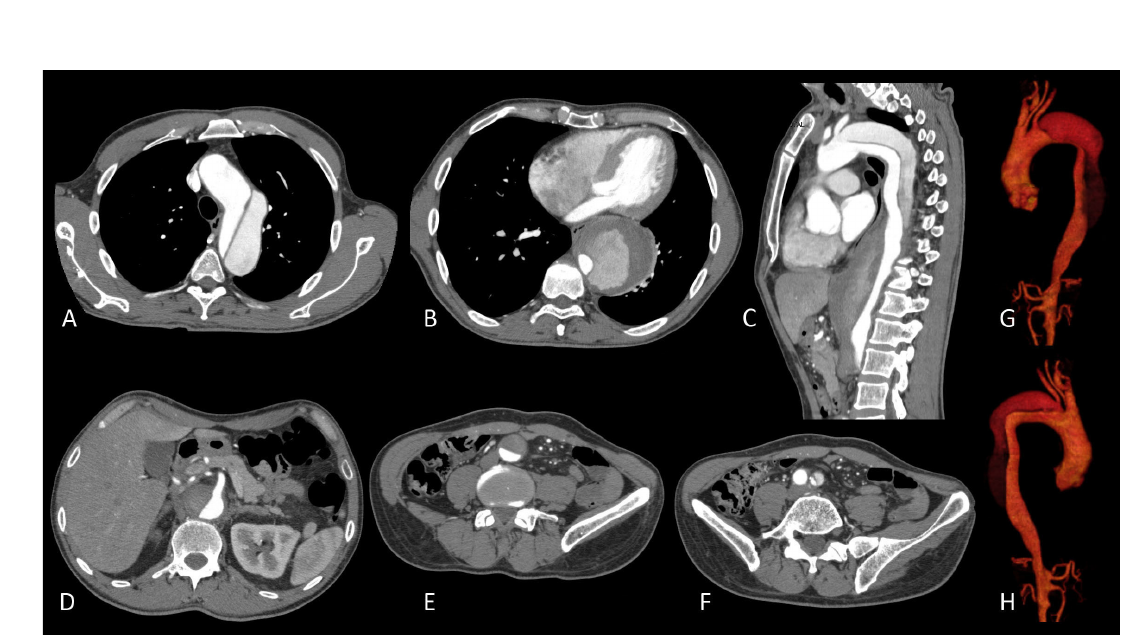
Fig. 1 - Angiotomography with multiplanar and three-dimensional reconstruction. A: Axial section demonstrating the dissection of the left subclavian artery origin. B: Larger diameter of the aorta. C: Sagittal section. D: Superior mesenteric artery originating from the true light. E: Involvement of the abdominal aorta. F: Dissection at the level of the left iliac artery. G: Three-dimensional reconstruction of the left anterior oblique. H: Three- dimensional reconstruction of the right anterior